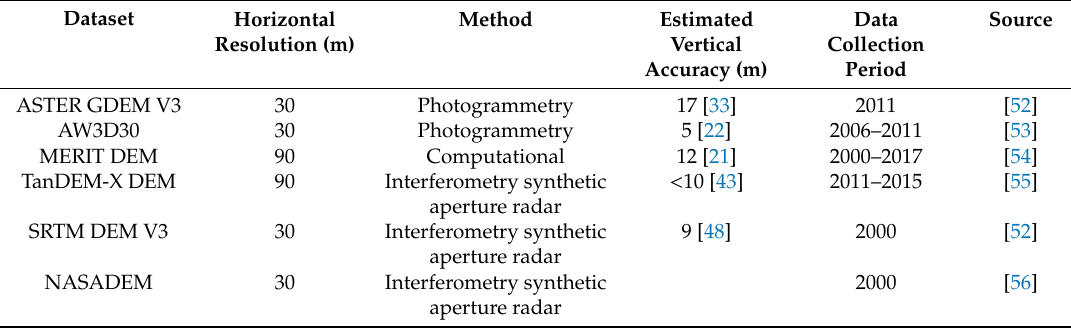
Table 1. Summary of the global digital elevation models (DEMs) evaluated in the present